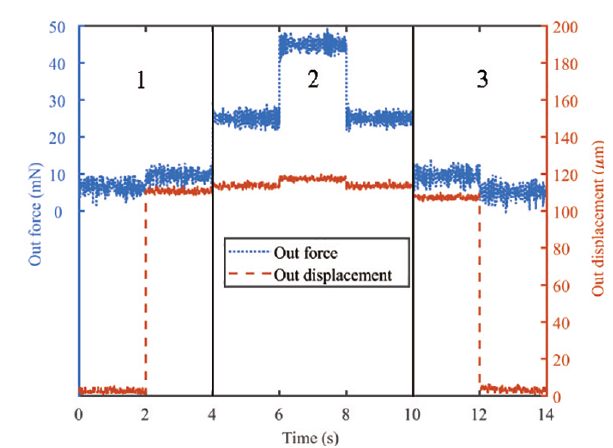
Figure 20. Experimental results of closed-loop gripping process test with position/force switch